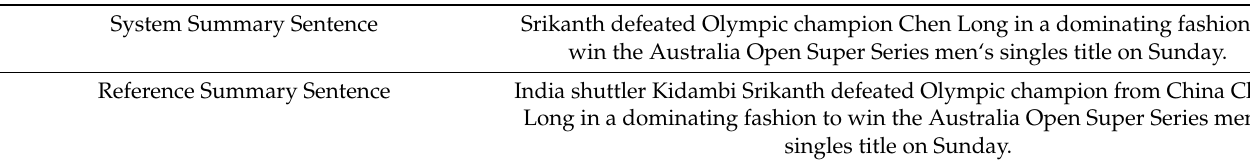
Table 5. Example of system and reference summary